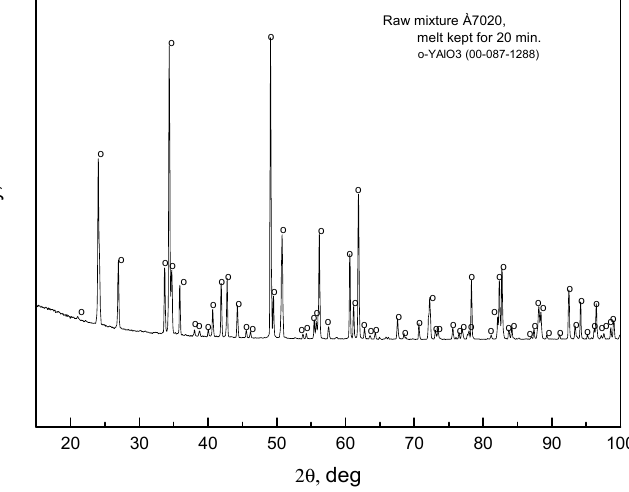
Figure 9. X-ray spectrum of raw oxides kept melted for 20 min.